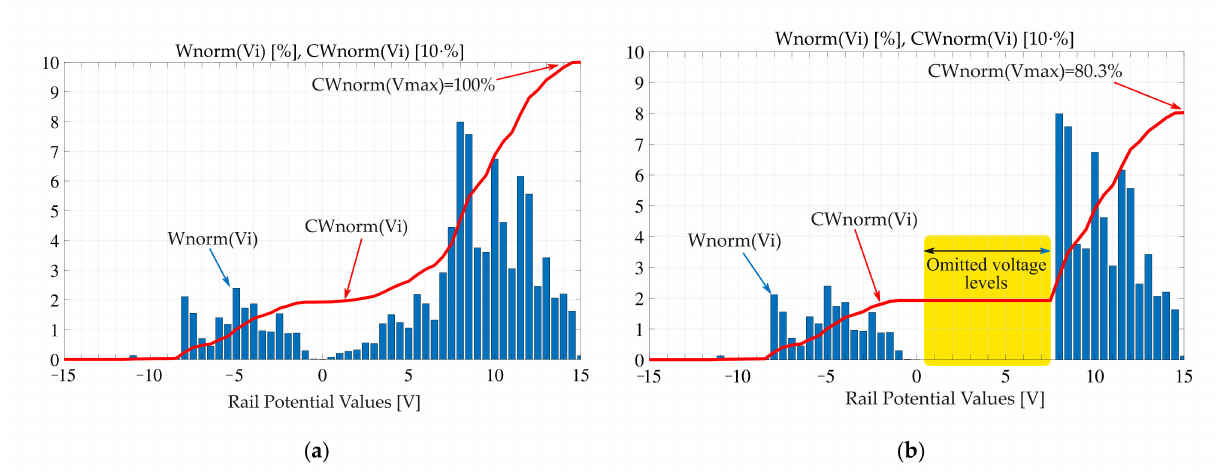
Figure 11. The distribution of energy vs potential values: ( a ) without charge balance; ( b ) using EGRA.